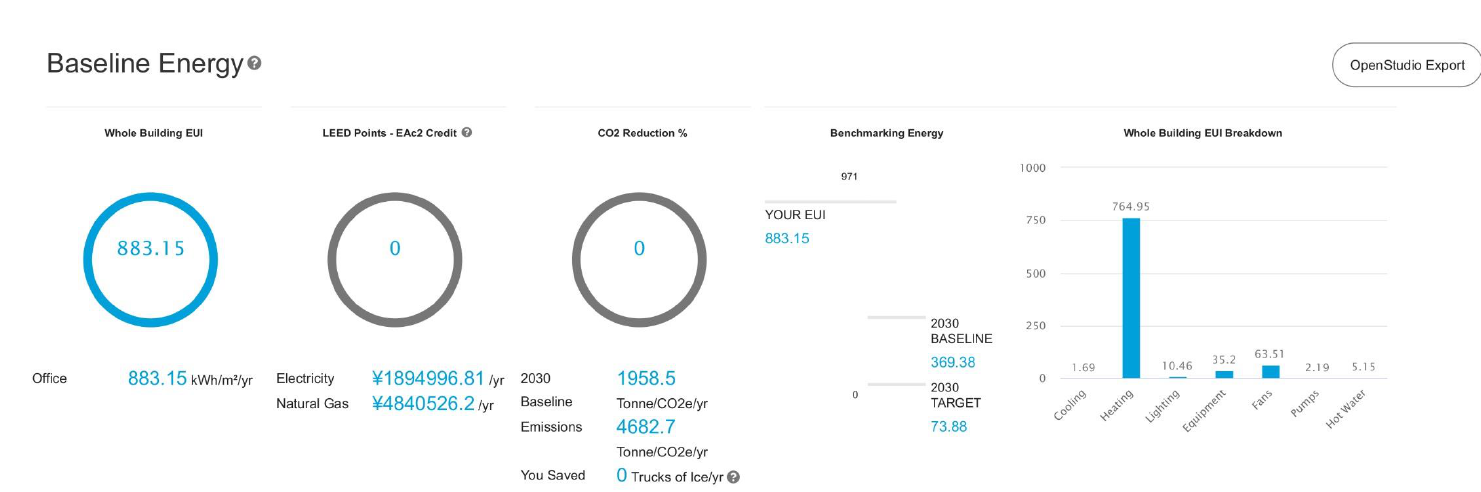
Figure A41. Zone 7 Harbin, Heilongjiang (post-COVID-19 78% scenario).